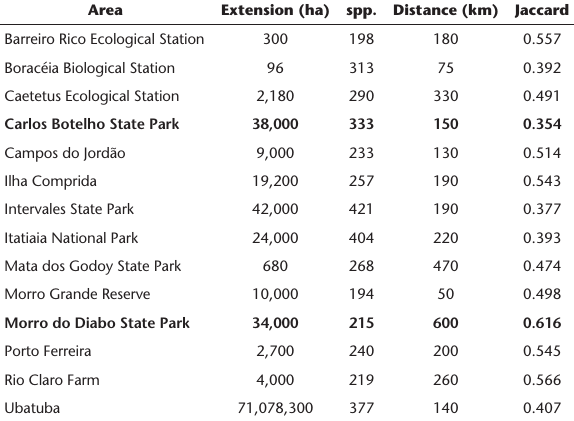
Table 2. Areas compared with Serra da Cantareira in multivariate analy- sis using presence/absence bird species data. spp. = number of species reported; Distance (km) = distance in kilometers from our study area; Jaccard = Jaccard dissimilarity index, the lower the number, the greater the similarity in avifauna composition with Serra da Cantareira. Areas with avifauna most (Carlos Botelho State Park) and least (Morro do Diabo State Park) similar to Serra da Cantareira are indicated in